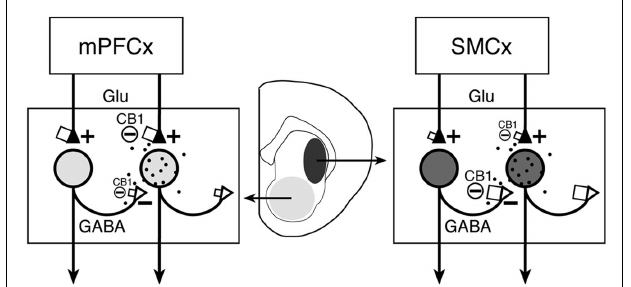
FIGURE 6 | Proposed differential CB1 regulation of collateral (GABA) inputs and cortical (glutamate, Glu) inputs to striatal projection neurons in associative/limbic vs. sensorimotor corticostriatal circuits. The proposed number of CB1 receptors on afferent terminals (see text) is indicated by the size of squares. Our present findings indicate an inverse relationship between cortical and striatal CB1 expression in associative/limbic circuits with inputs from medial prefrontal cortex (mPFCx) (left) and sensorimotor circuits (right), with relatively high cortical and low striatal CB1 expression in the former and low cortical and high striatal expression in the latter. It is argued that, in sensorimotor corticostriatal circuits, striatal CB1 receptors are mainly located presynaptically on local axon collateral terminals of projection neurons (open triangles) and regulate GABA release from these terminals (see text). On the other hand, striatal CB1 receptors in associative/limbic circuits may mostly regulate excitatory inputs from the cortex (filled triangles) and other areas (and GABA inputs from interneurons; not shown).The degree of shading in striatal areas and respective neurons reflects the amount of CB1 receptor expression in these neurons.The black dots symbolize endocannabinoid release from striatal neurons. SMCx, sensorimotor